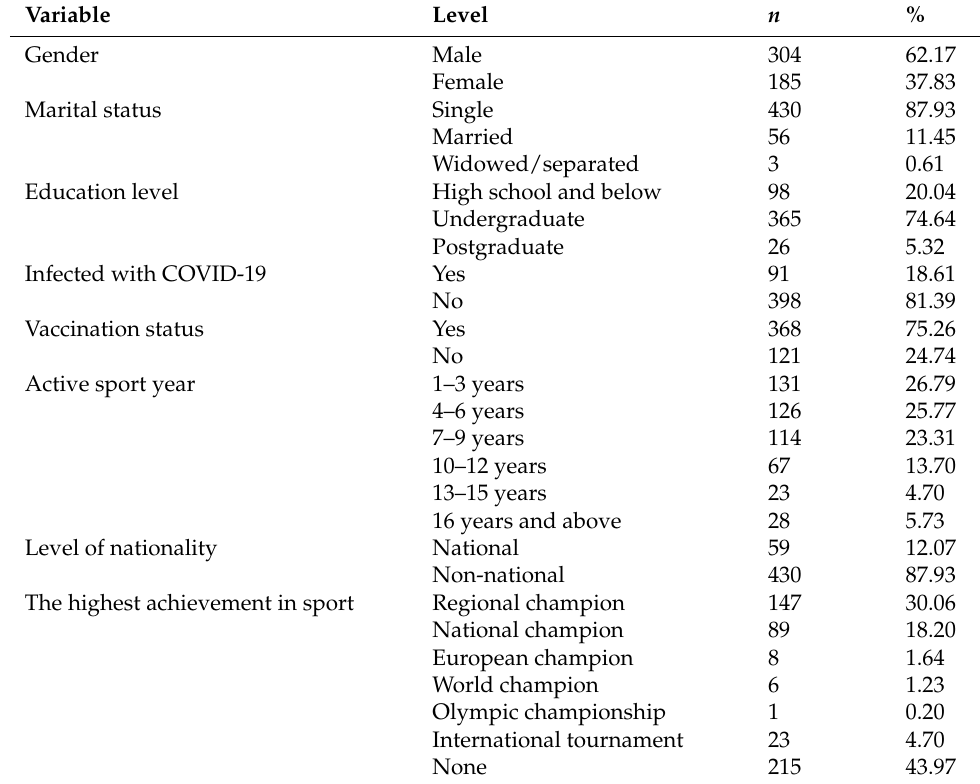
Table 1. Sample characteristics ( n =